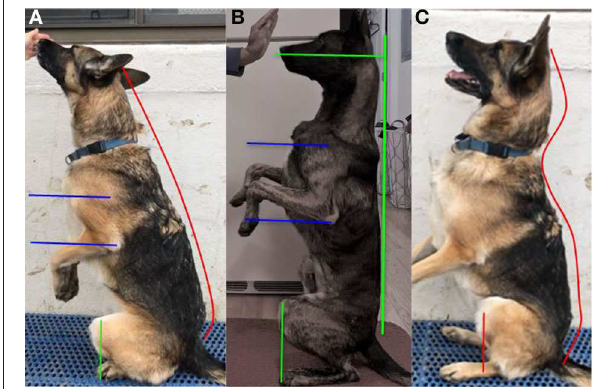
FIGURE 6 | (A) Shows the beginning progression of the Chipmunk—note the stifle dorsal to the digits. This position is held for < 2s. (B) Shows the correct Chipmunk position. The spine is straight, the stifles are dorsal to the digits, the carpi are suspended between the shoulders and elbows, and the head is in